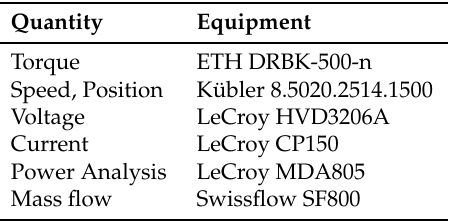
Table 6. Critical measurement